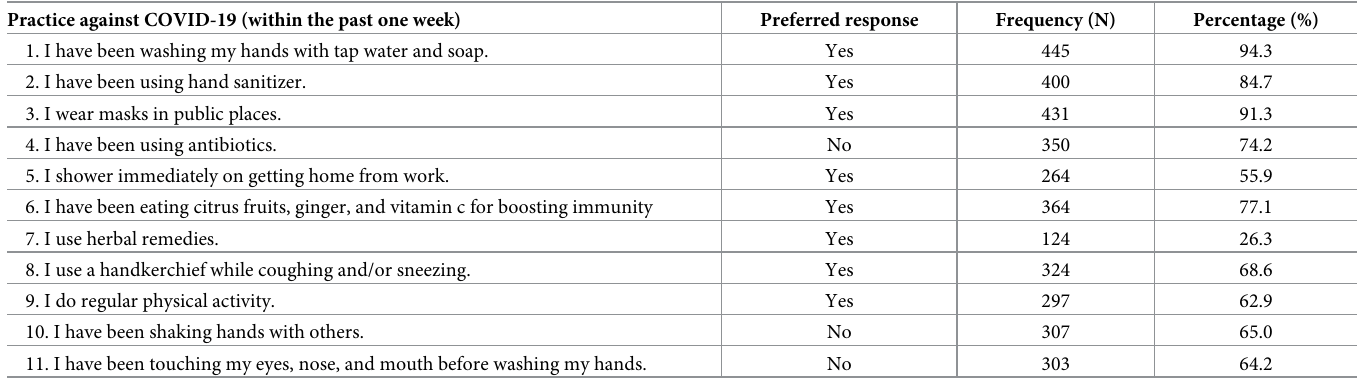
Table 3. Distribution of study participants according to their practice related to COVID-19. Practice against COVID-19 (within the past one week)